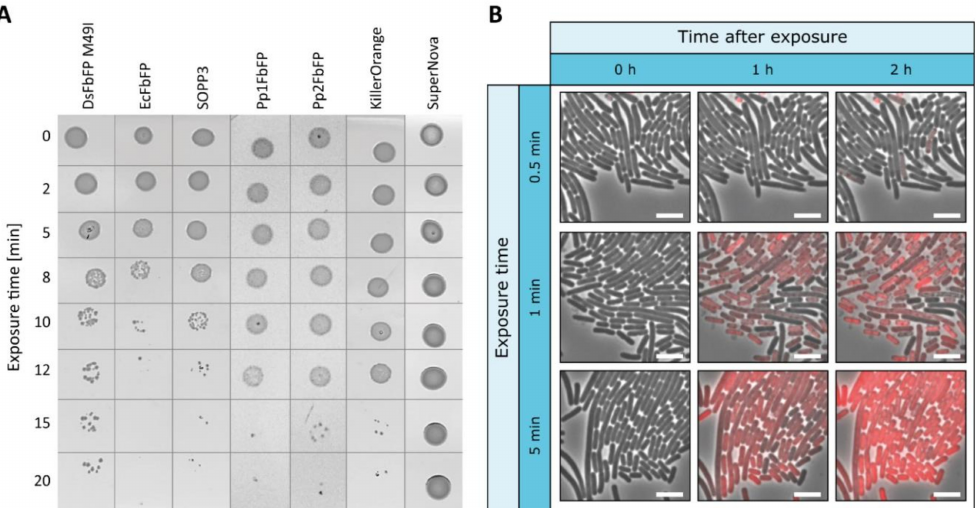
Figure 3. Extracellular antimicrobial activity of genetically encoded PSs on E. coli cells. ( a ) To investigate the e ff ect of extracellularly added PSs, purified proteins have been analyzed by a plate spot assay. For this, E. coli cells were supplemented with the respective PS variants adjusted to an OD 450 nm (or OD 580 nm in the case of SuperNova) of 0.2 and then illuminated for di ff erent time periods with intense (~130 mW cm − 2 ) blue ( λ max = 448 nm) or orange light ( λ max = 600 nm). Subsequently, 3 µ L of the irradiated cells were dropped on agar plates and incubated at 37 ◦ C overnight. To exclude blue light toxicity, a plate spot assay without the addition of a photosensitizer was performed as a control experiment (Supplementary Figure S3a). ( b ) Extracellular phototoxicity of SOPP3 on E. coli cells. Representative images from microfluidic experiments with extracellular SOPP3 (OD 450 nm = 0.3) addition and blue light exposure ( λ max = 445 nm). Images are shown for selected exposure times (0.5 min, 1 min, 5 min) and times after exposure (0 h, 1 h, 2 h). Scale bar = 5 µ